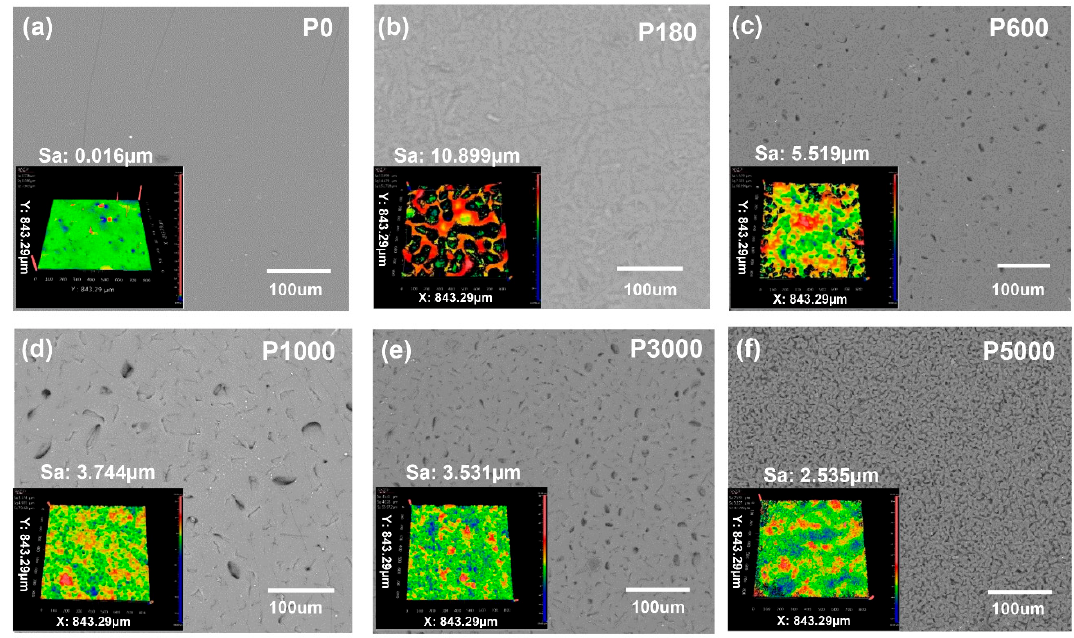
Figure 3. SEM morphologies of PDMS composites with different surface roughness. Insets illustrate the corresponding surface roughness. ( a – f ) The roughness of sandpapers corresponds to P0, P180, P600, P1000, P3000 and P5000, respectively. Note: “Sa” is average surface roughness.